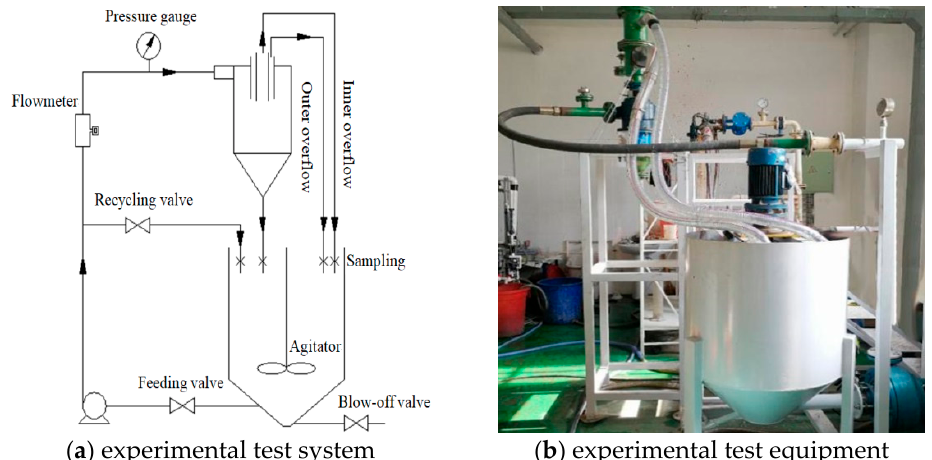
Figure 2. Hydrocyclone separator system experimental configuration.